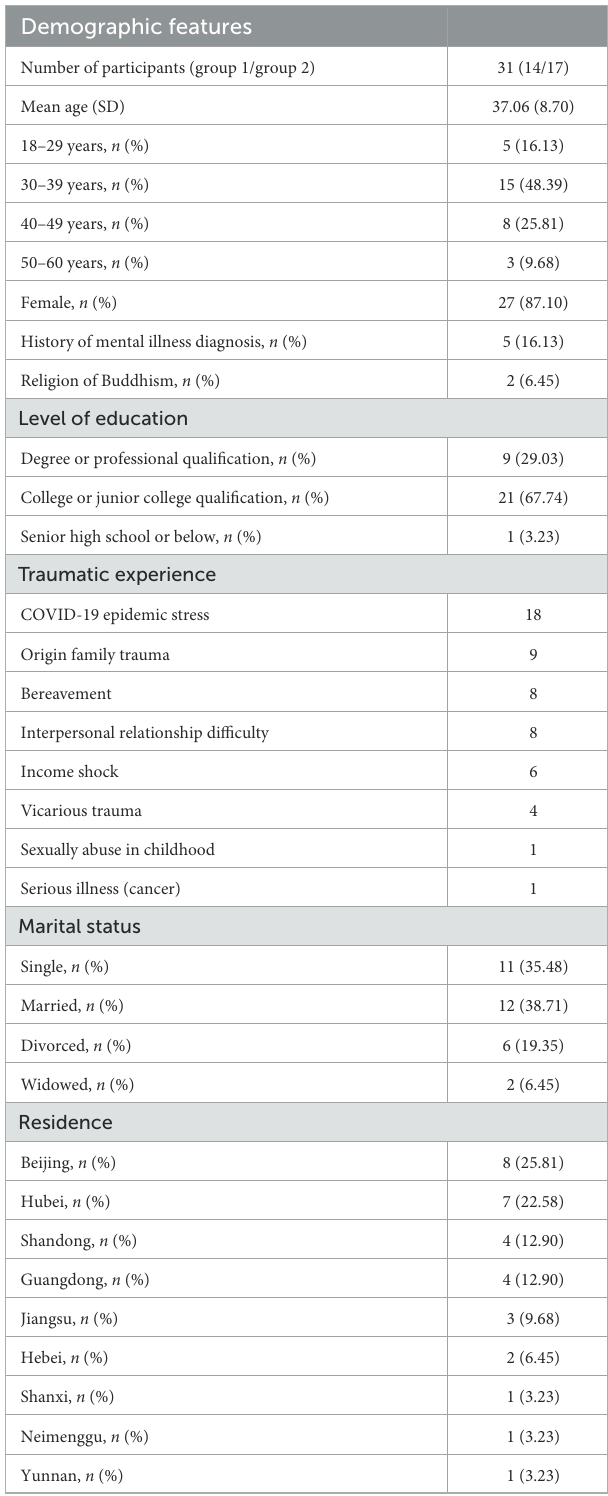
TABLE 2 Participants’ demographic information ( N =